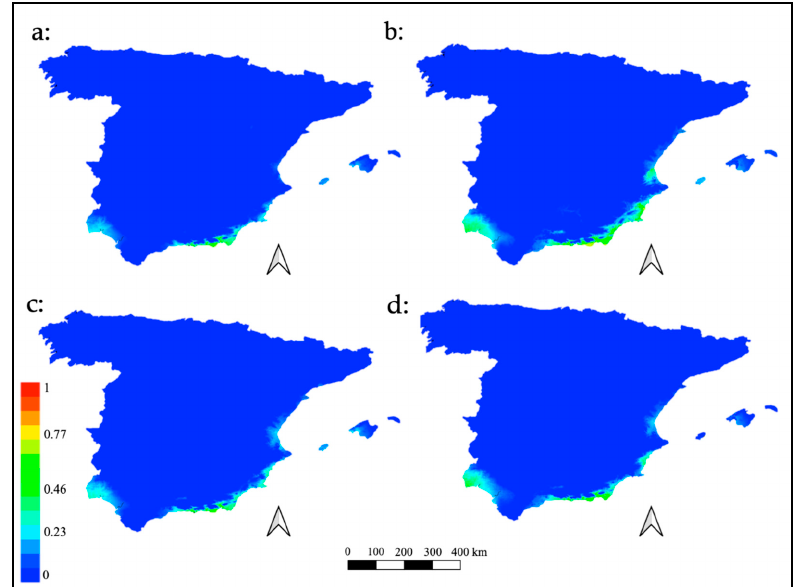
Figure 4. Future distribution models for M. europaea . Plots of the potential habitat projected into the future according to the representative concentration pathways: ( a ) RCP2.6; ( b ) RCP4.5; ( c ) RCP6.0; ( d ) RCP8.5.